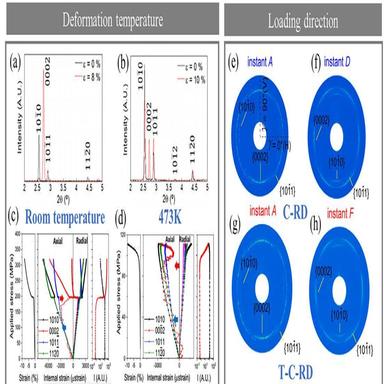
Diffraction patterns and compressive true stress–true strain curves at different deformation parameters. (a, b) axial diffraction patterns at room temperature and 473 K; (c, d) compressive true stress–true strain curves at room temperature and 473 K ; (e–h) 2D XRD diffraction patterns for the C-RD and T-C-RD tests .